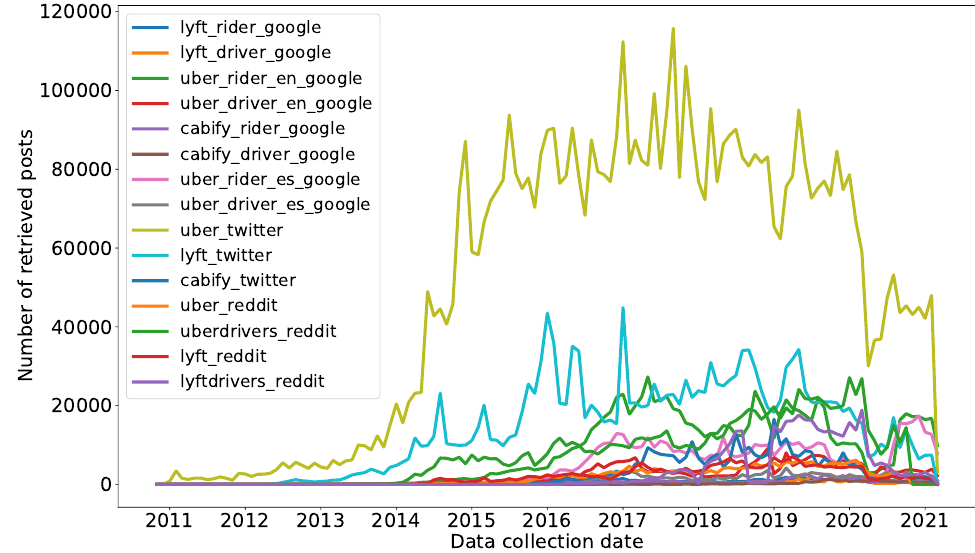
Figure 8. Total retrieved data per retrieval date.